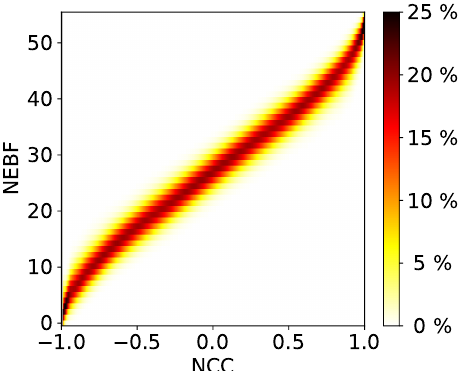
Figure 11. Relation between the two pixel similarity measures. 2D histogram of all pairs of normalized cross correlation (NCC) and Number of Equal Binary Features (NEBF) for all pixel comparisons of a measurement with a sequence length of 10 image pairs. For better visibility, the histogram is normed to the total number of pixels which fall in the same cross correlation